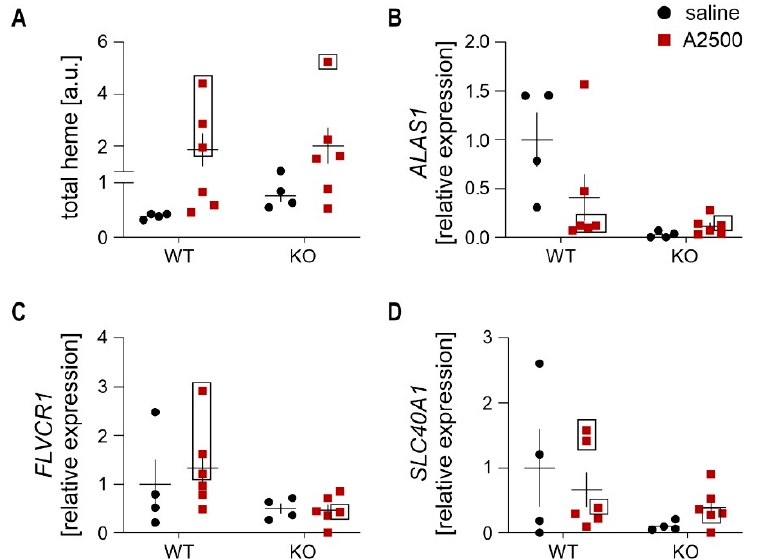
Figure 6. AngII infusion increases total heme content especially in AAA. The mice were infused with either saline or angiotensin II at the dose 2500 ng/kg/min using the osmotic pumps for 14 days. ( A ) Total heme content normalized to protein level. Two-way ANOVA with Tukey’s post hoc test. ( B – D ) Relative expression of ( B ) ALAS1 ; ( C ) FLVCR1 ; and ( D ) SLC40A1 in the abdominal aortic wall at day 14 after placement of osmotic pumps. eEF2 was used as a reference gene. Two-way ANOVA with Tukey’s post hoc test. Rectangle—mice which developed the aneurysm.